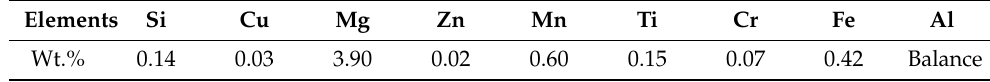
Table 1. Composition of 5083 Al alloy (mass